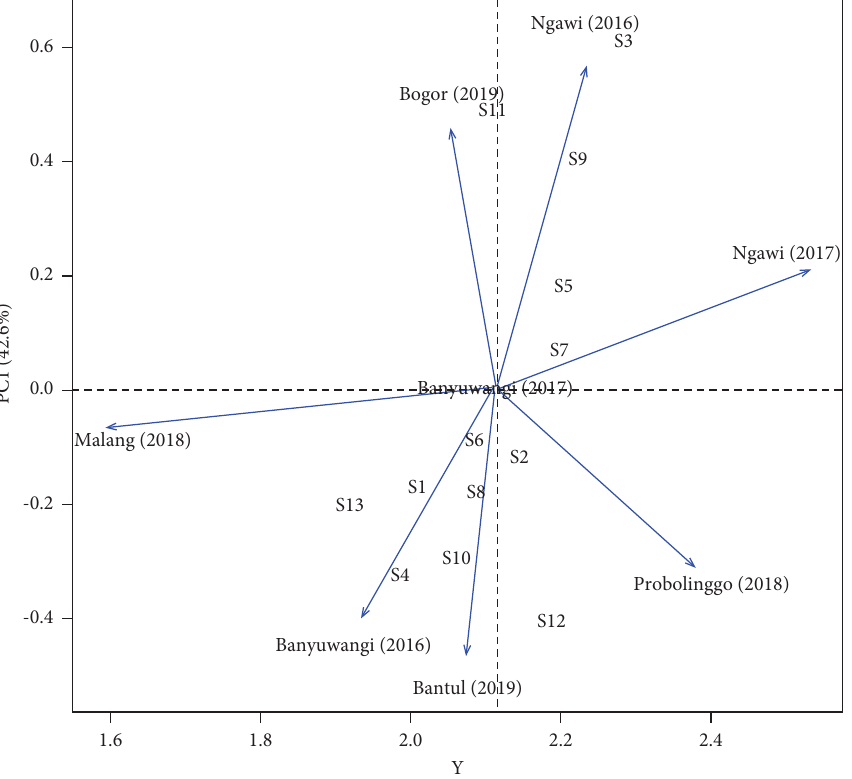
Figure 6: AMMI biplot “PC1 vs. yield” on 13 soybean lines in Indonesia during